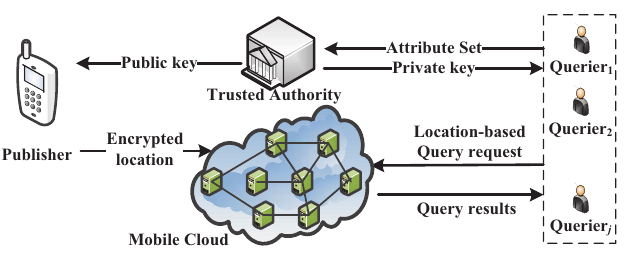
Figure 3. The mobile sensing service